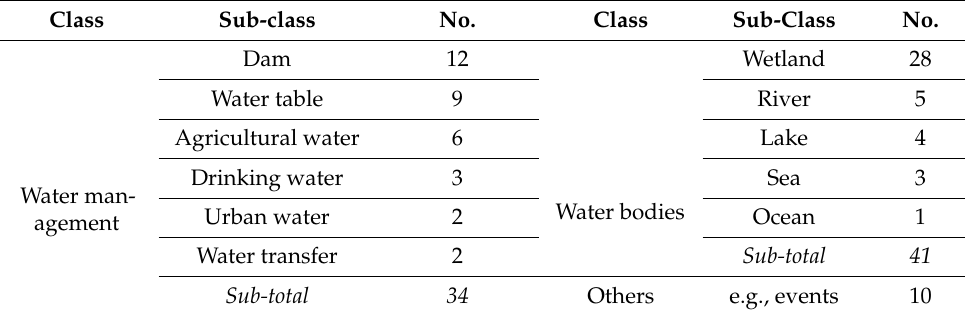
Table 4. Water-related news in the Iranian